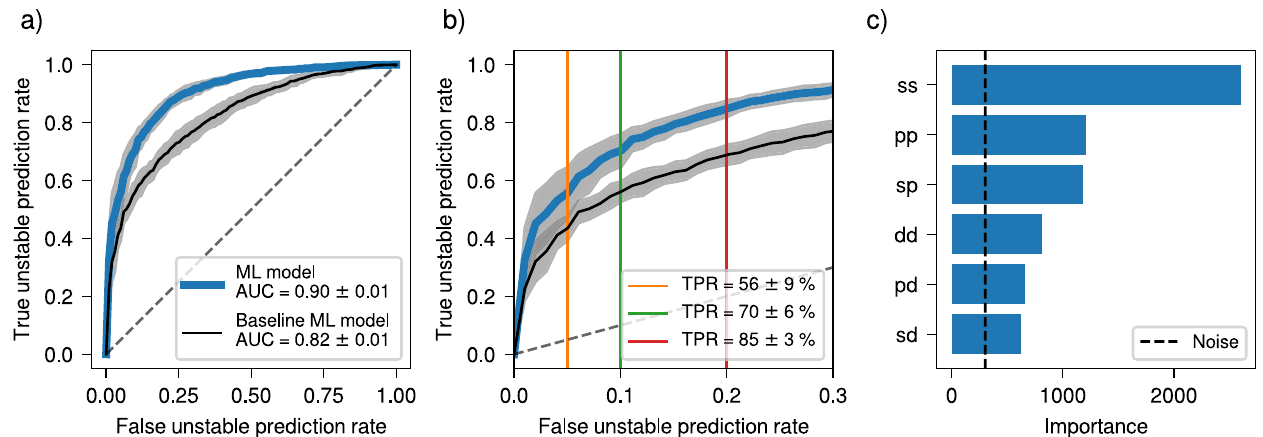
Fig. 9 Machine learning results. a Shows the ROC curves for a machine learning model trained on RAD-PDOS fi ngerprints and a baseline model trained on electronic features from the C2DB. The AUC scores are 0.91 and 0.82, respectively. b Shows the ROC curves zoomed on low false prediction rates with different classi fi cation thresholds highlighted with vertical lines. By accepting 5% of the stable materials being falsely characterized as unstable, we can correctly label 56 ± 9% of the unstable materials. For 10% the true prediction rate is 70 ± 6% and for 20% it is 85 ± 3%. c Shows feature importances of the different RAD-PDOS fi ngerprints measured as how many times the fi ngerprints are used to perform a split in the ML model. The RAD-PDOS ss fi ngerprint is found to be the most important fi ngerprint for the ML